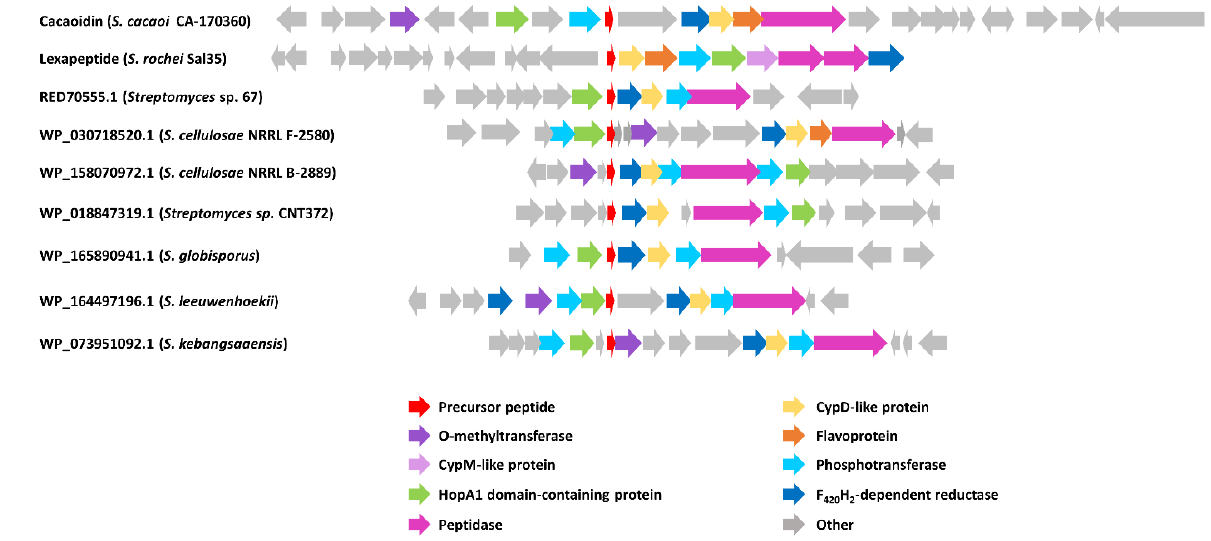
Figure 6. Schematic representation of cacaoidin BGC and the BGC of lexapeptide and other putative lanthidins (class V lanthipeptides). Accession numbers of each putative structural peptide are indicated.